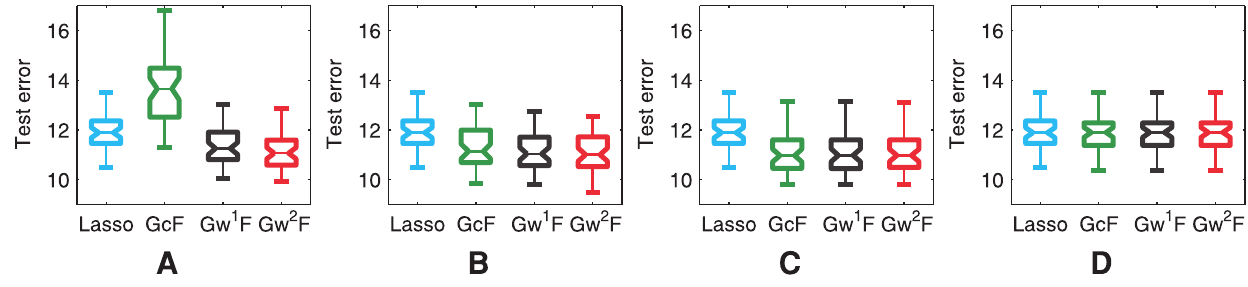
Figure 8. Comparison of association analysis methods in terms of phenotype prediction error. Panels show the prediction errors when the threshold r for producing the QTN is (A) r ~ 0 : 1 , (B) r ~ 0 : 3 , (C) r ~ 0 : 5 , and (D) r ~ 0 : 7 . The results were averaged over 50 simulated datasets. The box in each box plot shows the lower quartile, median, and upper quartile values, and the whiskers show the range of the prediction errors in the 50 simulated